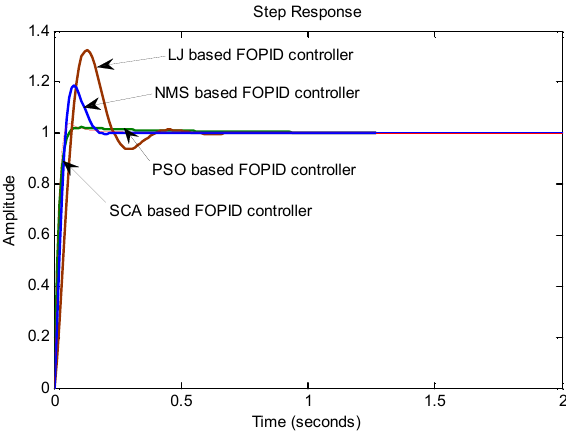
Figure 13. Step response of controlled HOCIP with the FOPID controller.